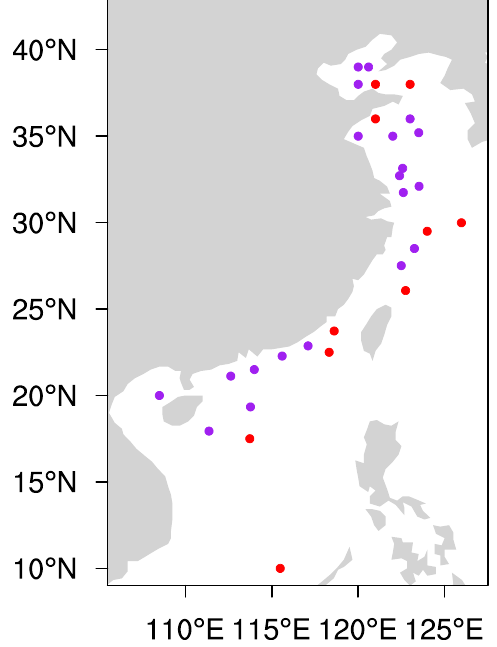
Figure 4. As in Figure 1, but for the HY − 2B matched buoy positions. The purple dots indicate the marched SWHs from the buoys that also have matched SWHs with CFOSAT, and the red dots indicate the matched SWHs from the buoys that only have matched SWHs with HY − 2B (30 buoys in total).